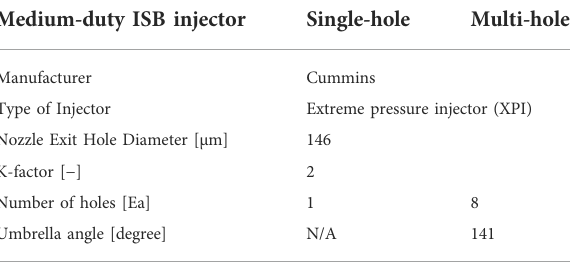
TABLE 4 Injector speci fi cation of the medium-duty ISB single- and multi-hole injectors. Medium-duty ISB